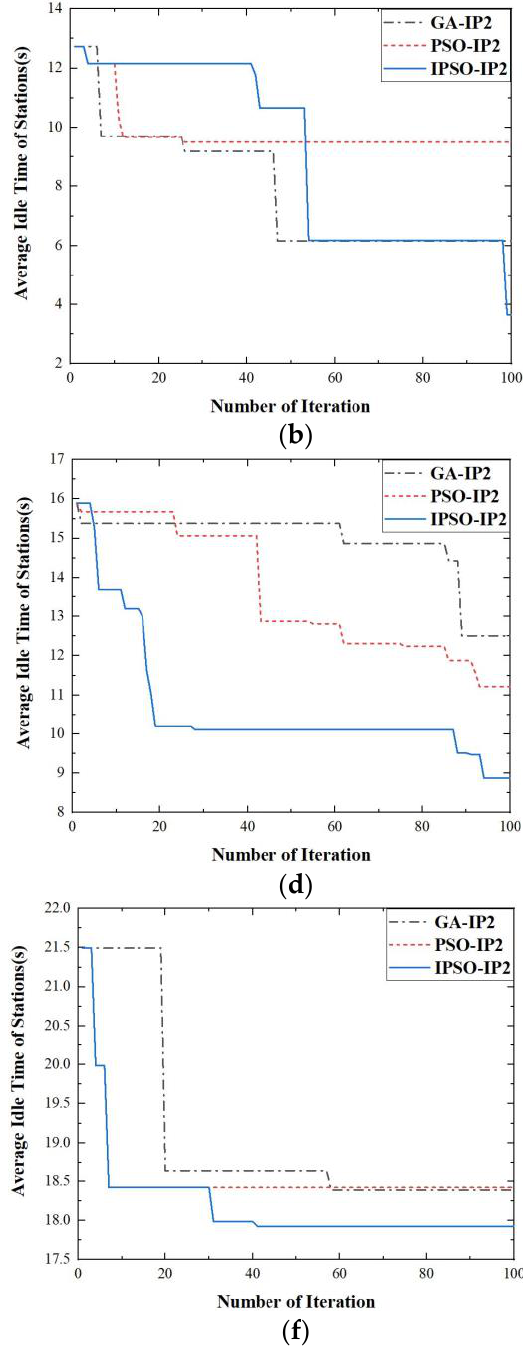
Figure 7. The graph of 100 iterations of GA-IP2, PSO-IP2 and IPSO-IP2. ( a ) The test samples is the first set of test samples. ( b ) The test samples is the second set of test samples. ( c ) The test samples is the third set of test samples. ( d ) The test samples is the fourth set of test samples. ( e ) The test samples is the fifth set of test samples. ( f ) The test samples is the sixth set of test samples.